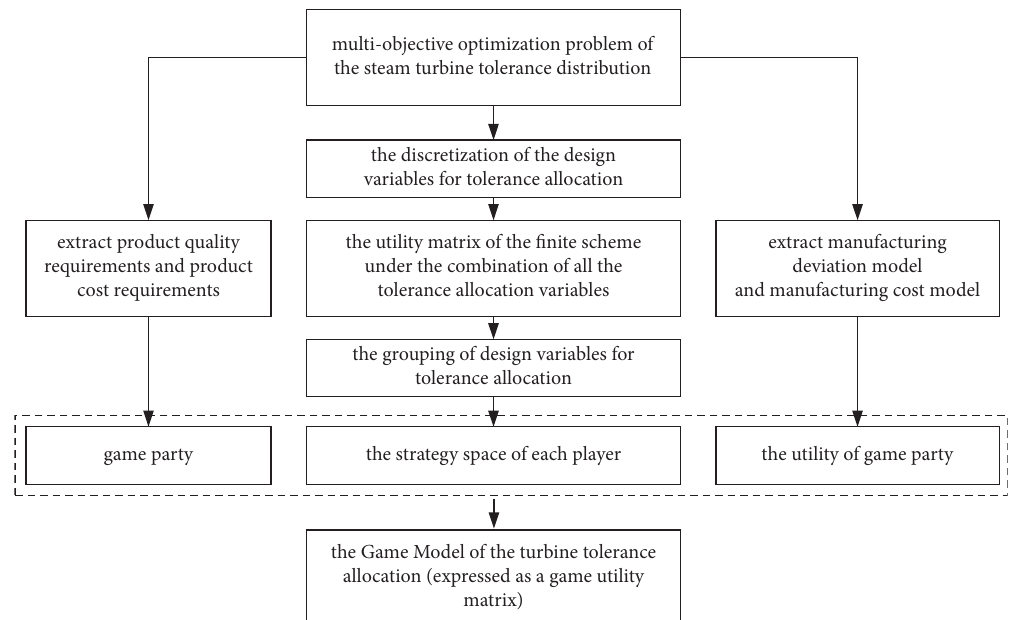
Figure 1: Construction process of optimization model of steam turbine tolerance allocation based on cooperative game